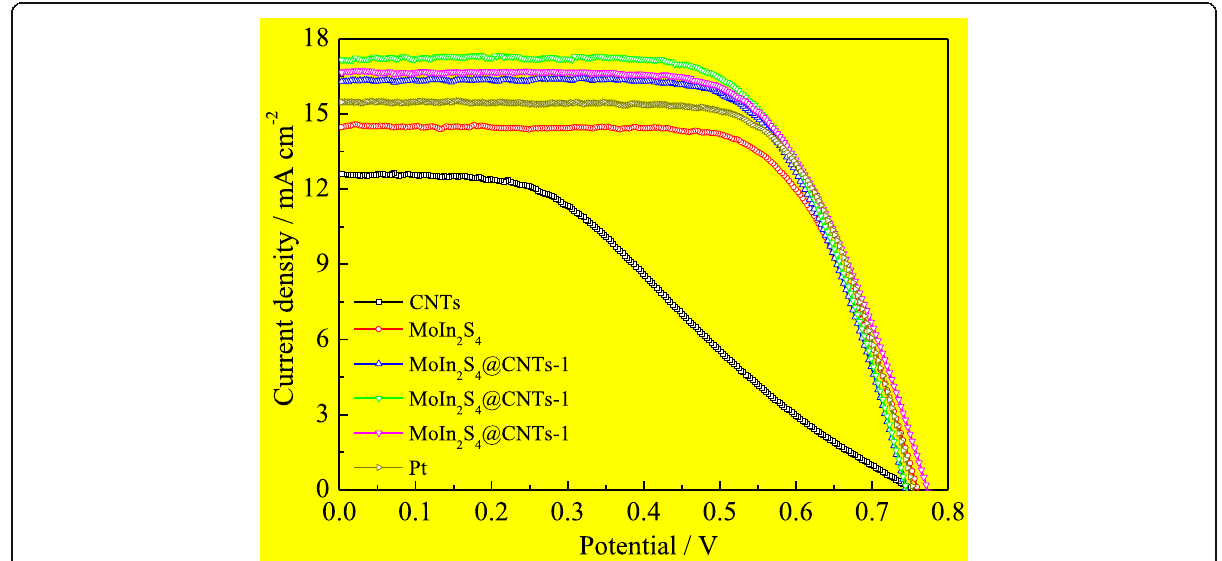
Fig. 8 J - V characteristics of the DSSCs fabricated with different